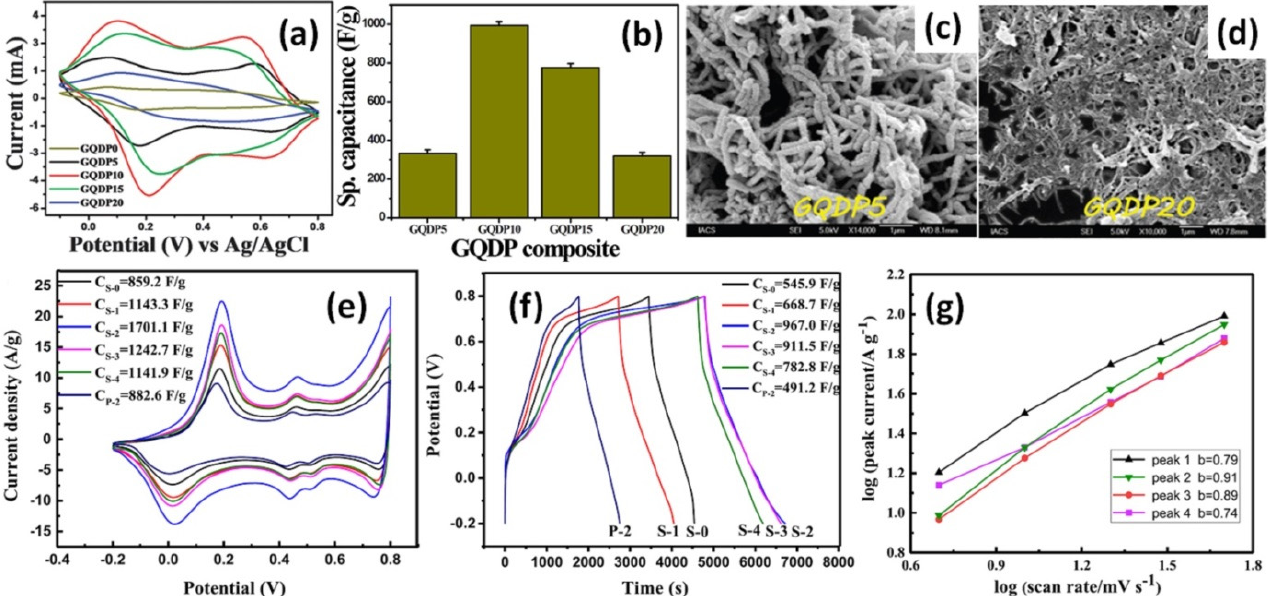
Figure 5. CV study of GQDP composites at the scan rate of 100 mV/s ( a ), Specific capacitance value of different GQDP composites ( b ), SEM images of synthesized GQDP composites having 5 wt% ( c ) and 20 wt% ( d ) GQDs (Reprinted from [70] with permission of RSC Publishing). CV curves of G-PC electrodes at a scan rate of 5 mV/s ( e ), GCD curves of G-PC electrodes at current density of 0.5 A/g ( f ) (0, 10, 20, 30, 50 wt% GNS-NH 2 designated as S-0, S-1, S-2, S-3, S-4), and logarithm peak current vs logarithm scan rate plots of S-2 (inset: a summary of the calculated parameter b values) ( g ) (Reprinted from [66], Copyright 2020, with permission from Elsevier)].